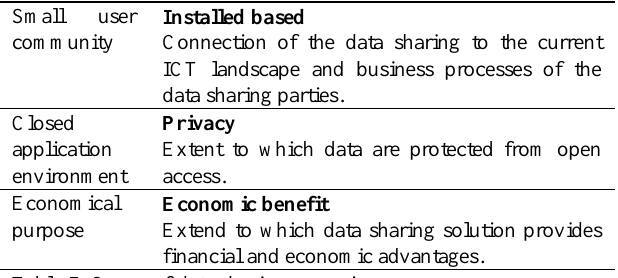
Table 7. Scope of data sharing